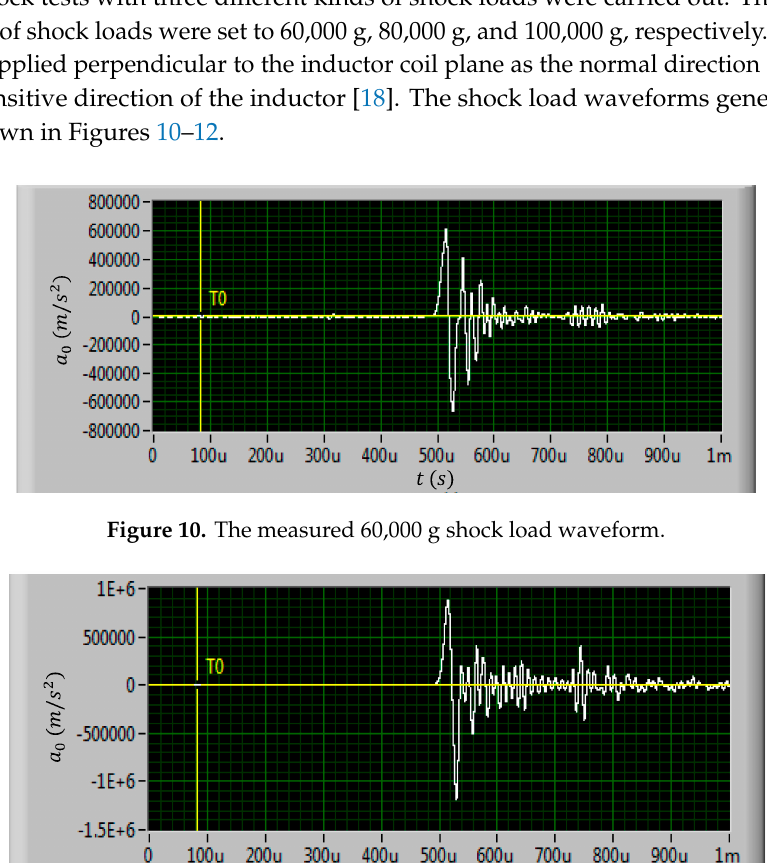
Figure 9. The shell with inductor dies for shock test. ( a ) The designed test shell structure. ( b ) The test shell with inductor dies.